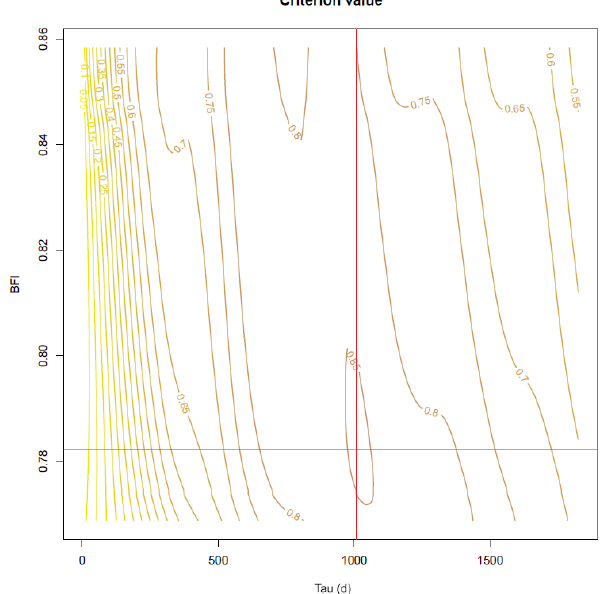
Figure 4. Surface plot of the optimisation criterion for the Petit Thérain River in Saint-Omer-en-Chaussée. The red cross indicates the numerical optimum.